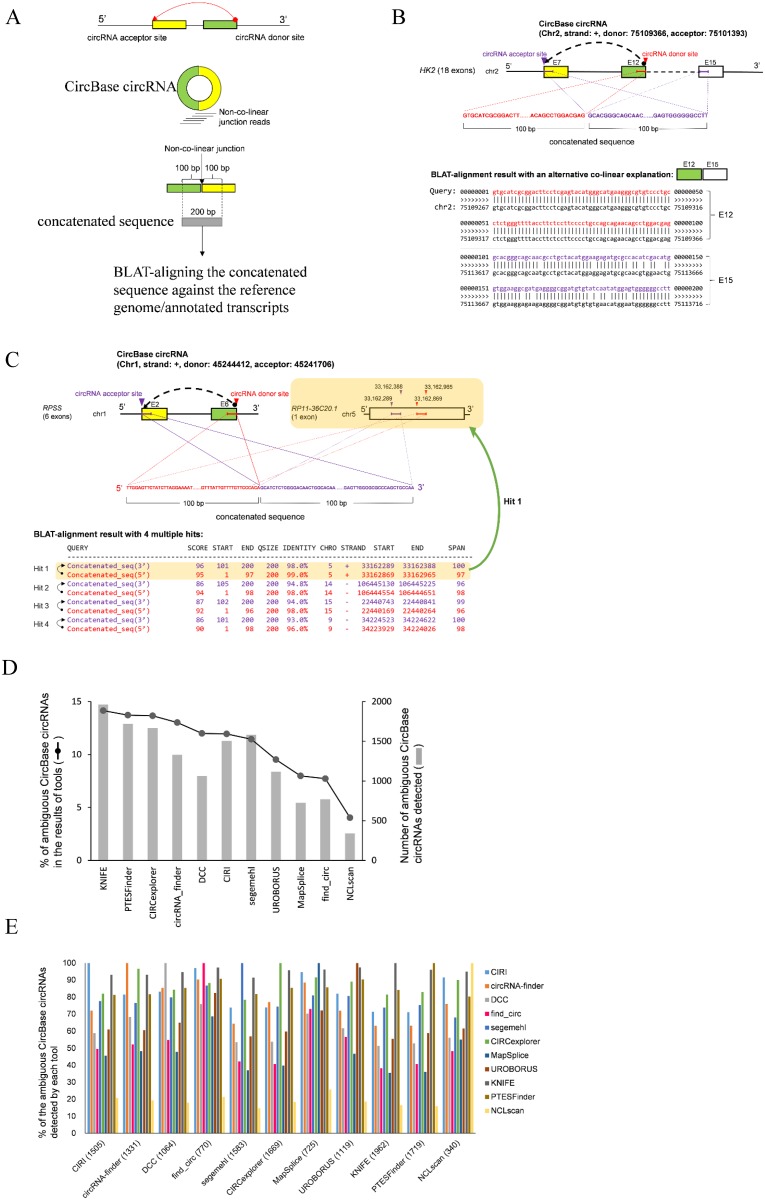
Detection of CircBase circRNAs with ambiguous alignments.(A) Schematic illustration of a concatenated sequence derived from a CircBase circRNA. (B and C) Examples of CircBase circRNAs with an alternative co-linear explanation (B) and multiple hits (C). For (B), the concatenated sequence of the CircBase circRNA (E12-E7) had an alternative co-linear explanation (E12-E15). For (C), the concatenated sequence of the CircBase circRNA (E6-E2) mapped to multiple positions (Hits 1–4). E, exon. (D) Distribution of the ambiguous CircBase circRNAs (2,316 events) in the results of the 11 tools (see also S2 Dataset). (E) Percentage of the ambiguous CircBase circRNA candidates of a tool when considering another circRNA predicting tool. The numbers in parentheses were ambiguous CircBase circRNA candidates detected by each tool.